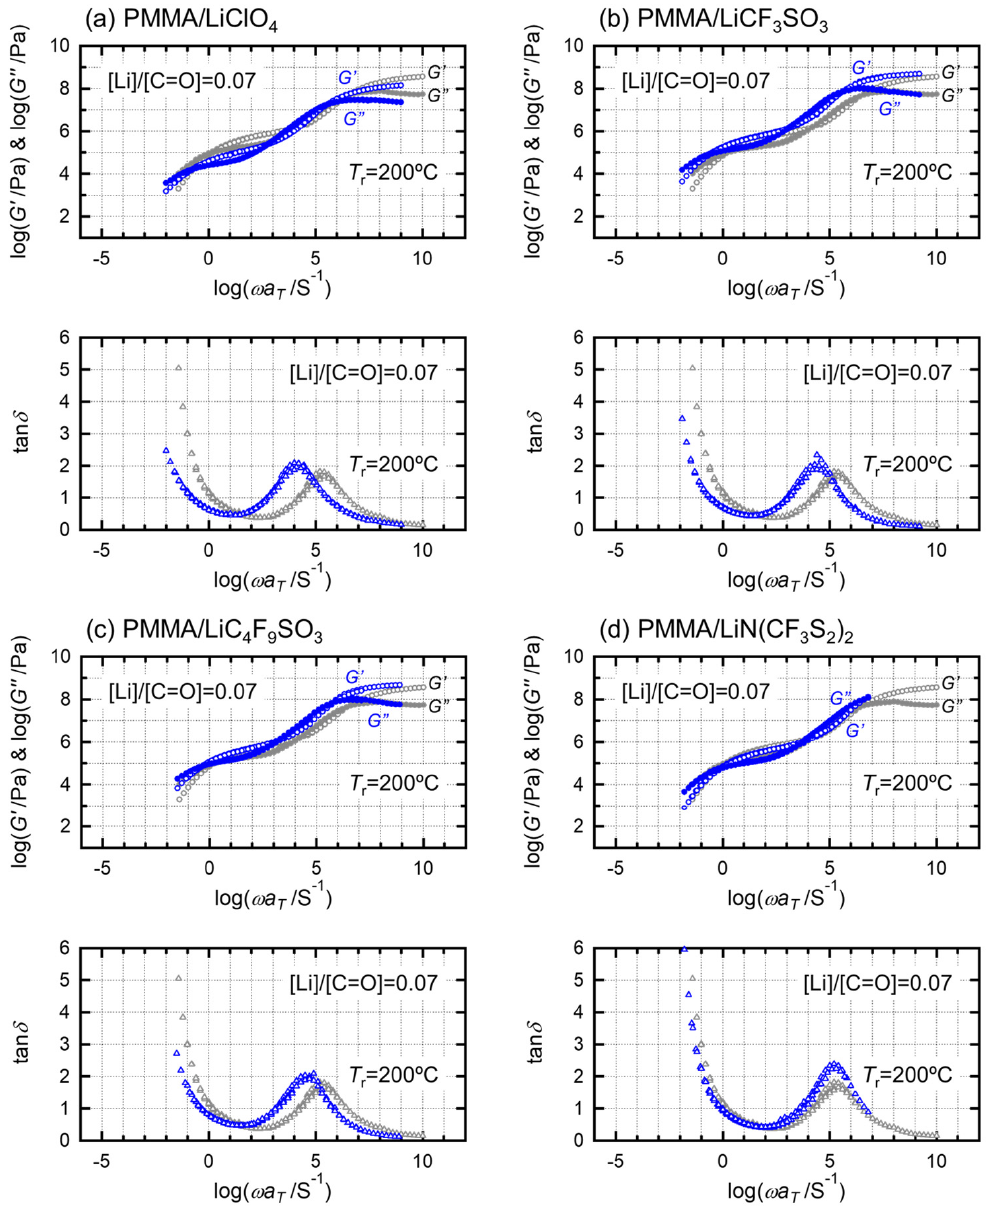
Figure 2. Dynamic viscoelastic spectra in the melts. PMMA (gray) and PMMA doped with the different lithium salts (blue): ( a ) LiClO 4 , ( b ) LiCF 3 SO 3 , ( c ) LiC 4 F 9 SO 3 , and ( d ) LiN(CF 3 SO 2 ) 2 , with a 0.07 molar ratio salt concentration. The open circle denotes G ′ ; the closed one denotes G ″ ; the open triangle denotes tan δ .